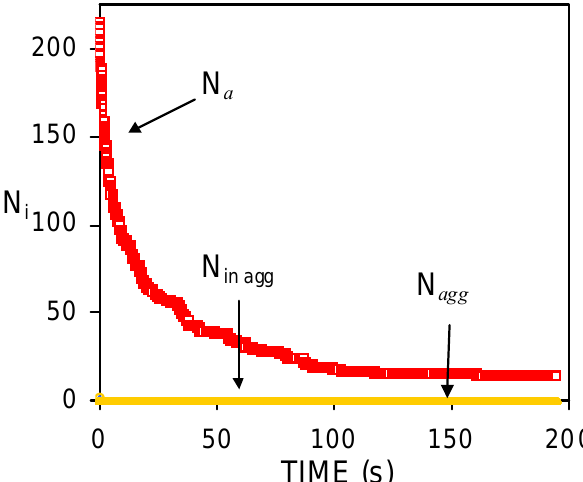
Figure 3. Smoluchowskian decrease of the number of aggregates as a function of